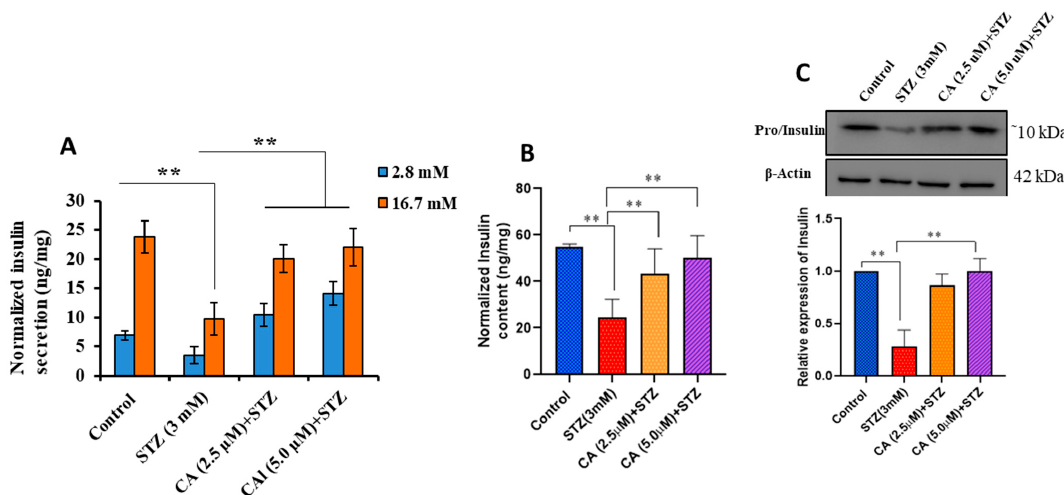
Figure 2. Impact of CA on insulin secretion, content, insulin expression in INS-1 cell treated with 3 mM STZ treatment. ( A ) Normalized stimulated insulin secretion was determined by ELISA in response to 2.8 and 16.7 mM glucose, respectively. ( B ) Normalized insulin content. ( C ) Western blot analysis of INS (Pro/Insulin), all in STZ-treated cells or cells preincubated for 24 h with CA followed by STZ treatment compared to control cells. β -actin was used as a reference control for Western blot. Data presented are obtained from three independent experiments. ** p < 0.01, and bars represent mean ± SD.